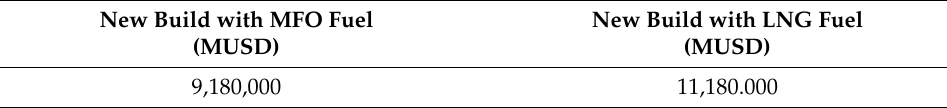
Table 2. Estimated new build 600 TEU container vessel.